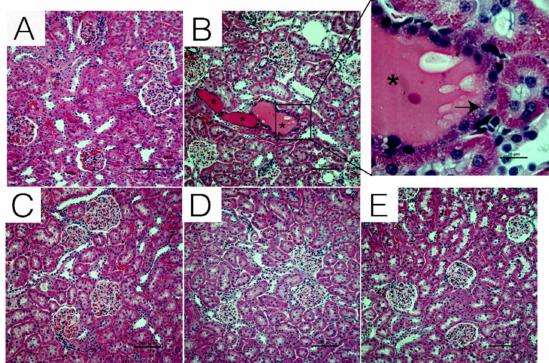
Figure 2. Histological evaluation of the effects of chrysin on CsA-induced tubular damage. Male Sprague Dawley rats were treated with CsA in combination with or without chrysin. Rats were euthanized on day 28; the kidneys were removed and fixed, and tubular damage was visualized using H&E staining. Compared to rats treated with ( A ) vehicle or ( C ) 50 mg/kg chrysin, tissue from animals treated with 25 mg/kg CsA ( B ) showed tubular dilation and edema. Appearance of casts (asterisk in the inset of B) and tubular vacuolization (black arrow in the inset) were also seen in kidneys from animals treated with CsA alone. Co-treatment with ( D ) 25 mg/kg CsA + 50 mg/kg chrysin or ( E ) 25 mg/kg CsA + 10 mg/kg chrysin showed no signs of tubular damage. Representative micrographs are shown at a magnification of 200 × (inset 1000 × ). The scale bar represents 100 µ m (panel ( B ) inset scale bar represents 20 µ